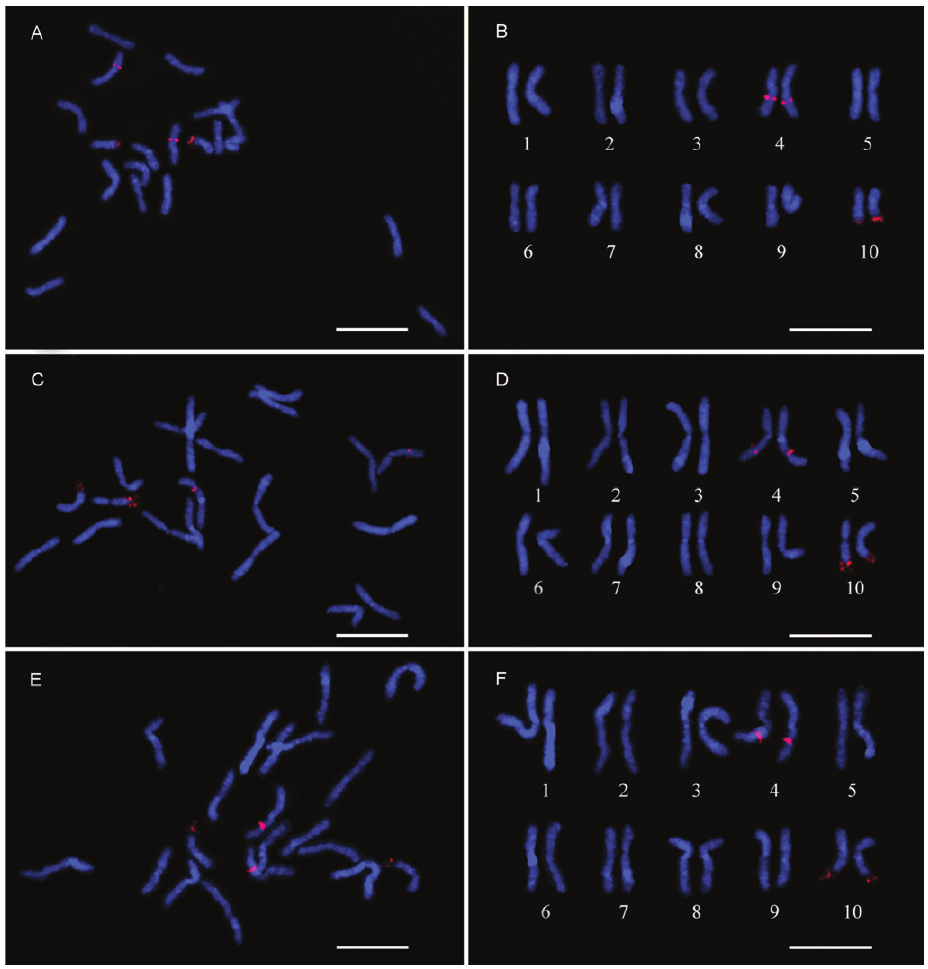
Fig. 3, A-F. FISH with histone H3 gene probe applied on chromosomes of Crassostrea gigas (in red). The chromosomes were contrasted with DAPI (blue). A - a metaphase cell with single/single signals on telomeres of pair 10, and B - its corresponding karyotype. C - a metaphase cell with double/double signals on telomeres of pair 10, and D - its corresponding karyotype. E - a metaphase cell with single/double signals on telomeres of pair 10, and F - its corresponding karyotype. Bars = 10